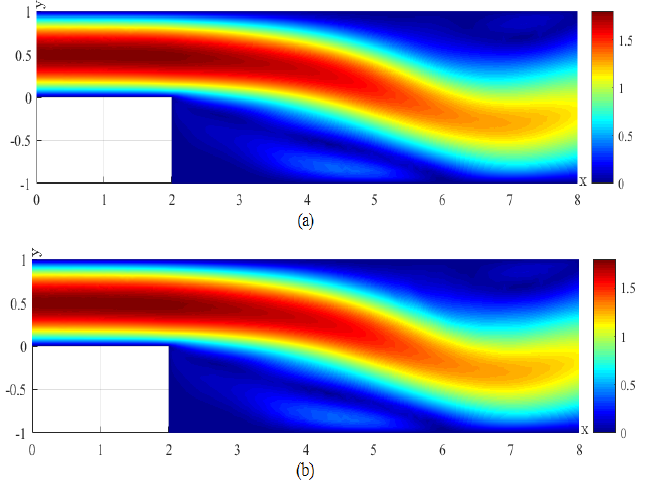
Figure 8. ( a ) The velocity magnitude for the CNMFE solution at t = 6. ( b ) The velocity magnitude for the RDRCNMFE solution at t =